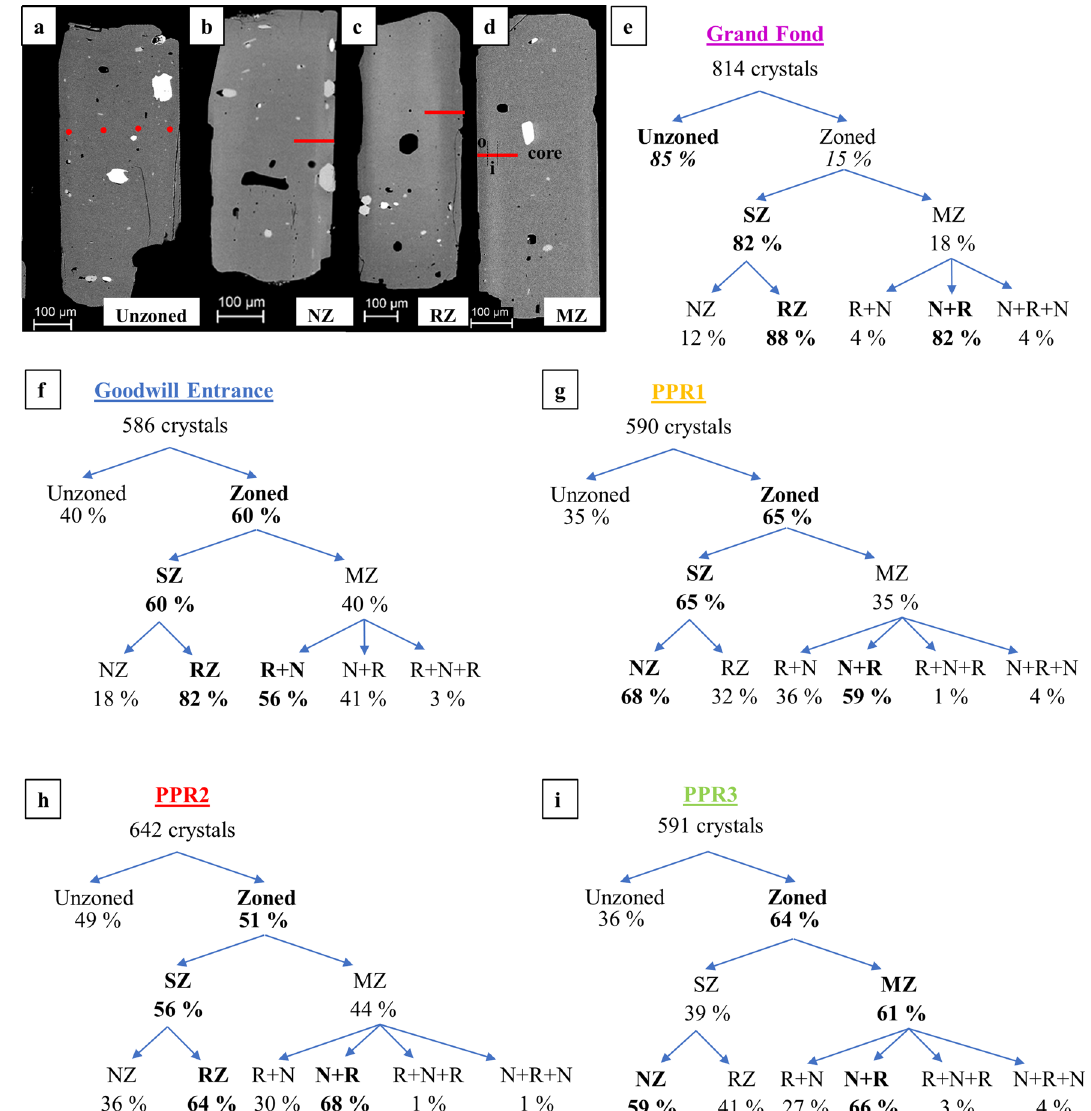
Figure 2. The different zonations identified in the opx cargo: images and proportions. SEM images (Sorbonne Université, Paris). ( a ) Unzoned crystal. Two types of single-zoned opx (SZ) have been identified: normal-zoned (NZ, b ), with a Mg-rich core (darker zone on a grayscale image) and Fe-rich rims (clearer in grayscale), or reverse-zoned (RZ, c ), with inversely a Fe-rich core and Mg-rich rims. ( d ) Multiple-zoned opx (MZ), either reverse + normal (R + N) or normal + reverse (N + R) or with a third rim (N + R + N or R + N + R, Supplementary Figure S3). The red line shows the location of the electron microprobe profiles (EPMA) and the core, inner (“i”) and outer rim (“o”) zones are annoted on the multiple-zoned opx ( d ). From ( e ) to ( i ) (drawn with Microsoft Office suite 2019 Version 1808; https:// www. micro soft. com/ fr- fr/ micro soft- 365): proportions of the zonations identified in the opx of Grand Fond in the 355–500 µm fraction ( e ) and in the opx of the small explosive eruptions of the three fractions studied all together (355–500, 250–355 and 125–250 µm fraction, f to i ). 4% of the multiple zoned crystals studied had a third rim (less than 5 crystals per eruption). However, this third rim, though existing in the crystal, does not form a plateau in the compositional profiles (< 10 µm), so they will not be considered in the following results (Supplementary Figure S3). These last rims could correspond to very shorts events prior to the tals (single- or multiple-zoned). For the four smaller eruptions, 258 profiles have been performed (72 for Good- will, 59 for PPR1, 61 for PPR2 and 66 for PPR3). All profiles in zoned opx were acquired perpendicular to the zone boundaries and to the long axes of the crystals, far from the corners to reduce the impact of 3-D diffusion effects or recrystallization along the c-axis (Fig. 2b–d) 25,42,43 . Opx compositions are spread over an En 46-59 compositional range (Figs. 3a1–c5 and 4a1–d5, Supplementary Figure S2). The unzoned opx of the five eruptions have a composition between En 50-56 (Fig. 3a1–a5). Based on the unzoned compositions and the cores compositions of the zoned opx, two populations of zoned opx have